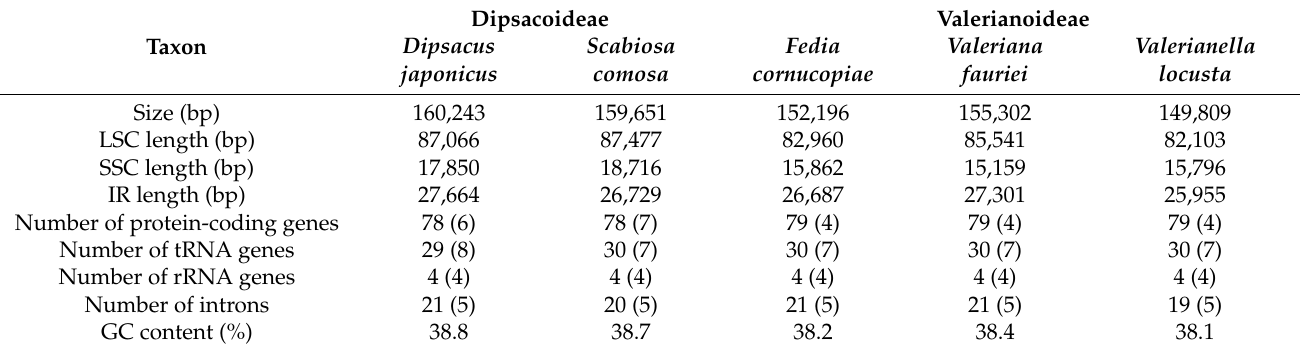
Table 1. Comparison of Caprifoliaceae plastomes sequenced in this